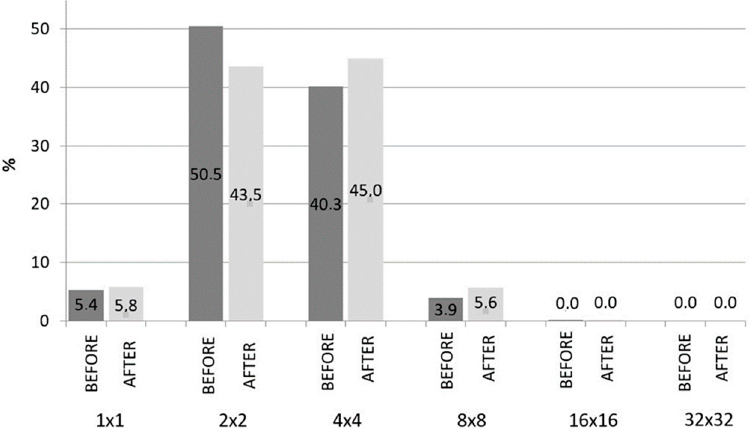
Table 3 . The number of blocks with sides of 1 x 1, 2 x 2, 4 x 4, 8 x 8, 16 x 16 and 32 x 32 pixels,